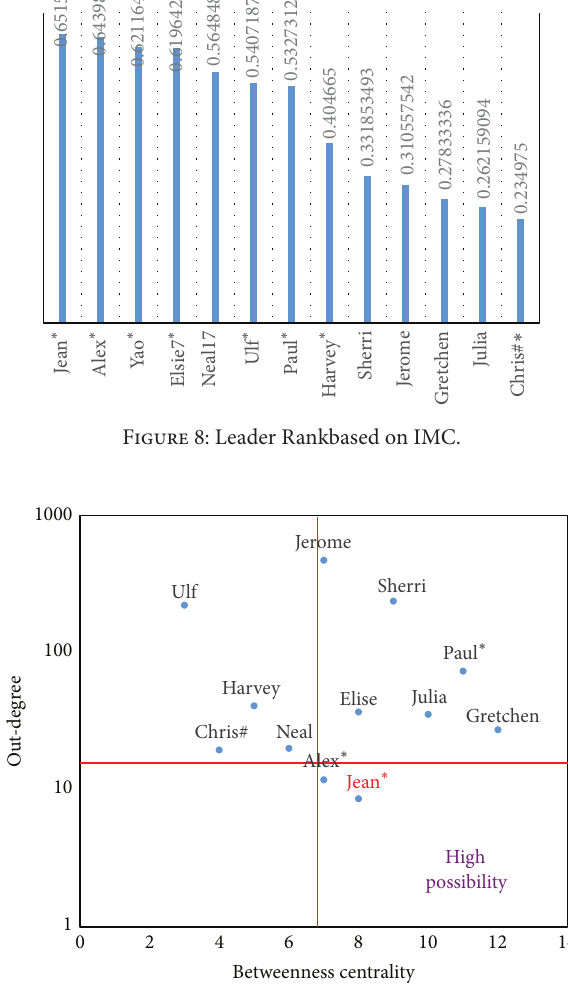
Figure 9: Joint distribution of betweenness centrality and out- degree. (Yao’s out-degree is 0, which means he could not be the leader